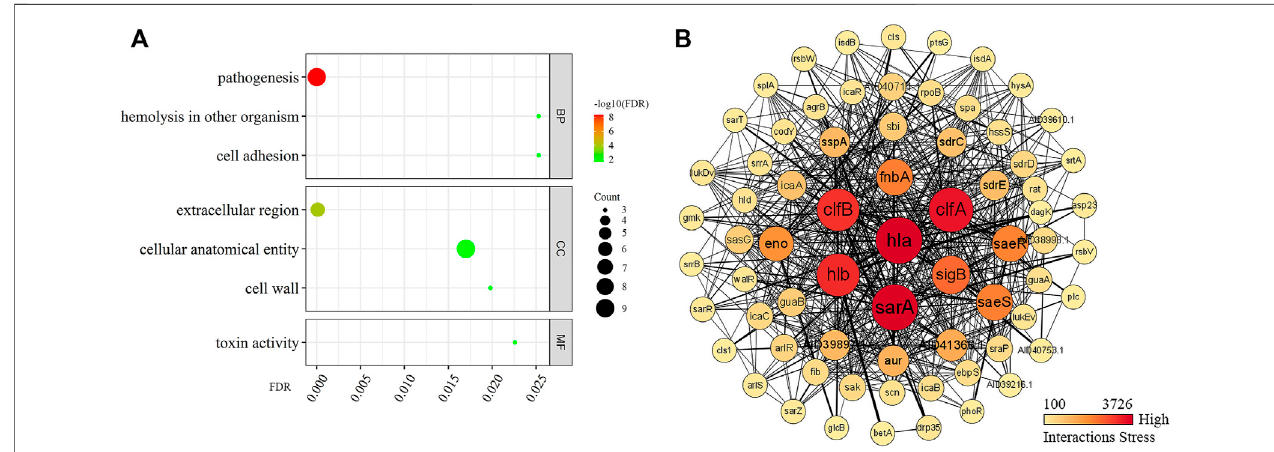
FIGURE 5 | Enrichment analysis of GO and PPI of Hla protein. Note: (A) presents the GO enrichment analysis; (B) presents the protein – protein interaction; Darker colors indicate higher importance in the interaction network; the stronger the interaction between two proteins, the thicker the linkage.